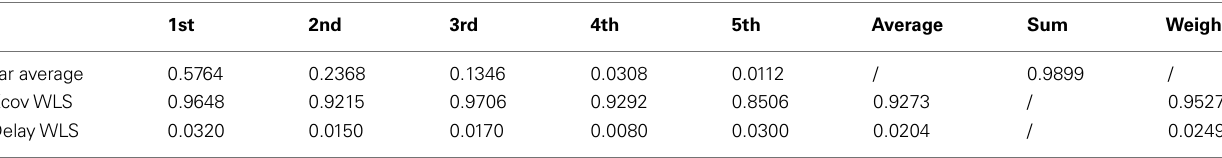
Table 2 |Walking at low velocity kMPs (5 subjects).